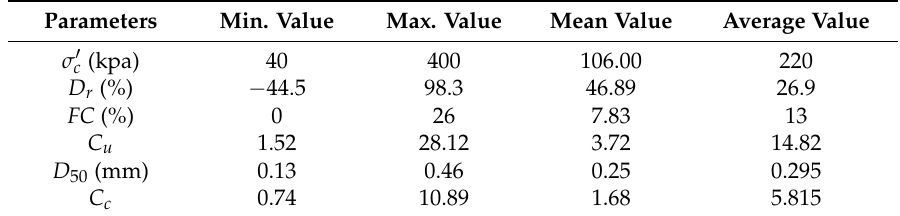
Table 3. Characteristics of the complete input parameters used for the second ANN model and RSM equation.